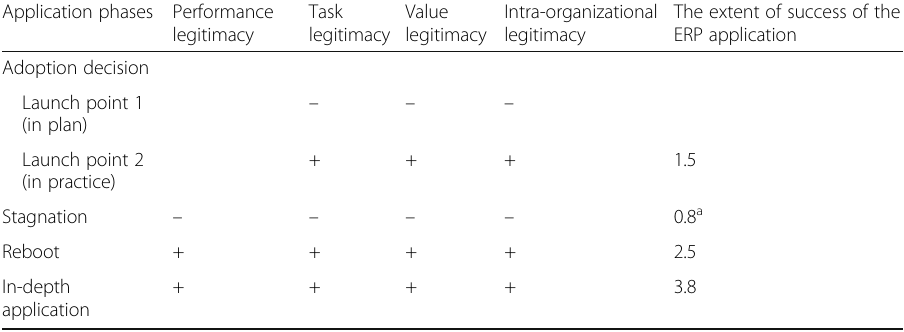
Table 2 Covariant relationship between the intra-organizational legitimacy of ERP and its application